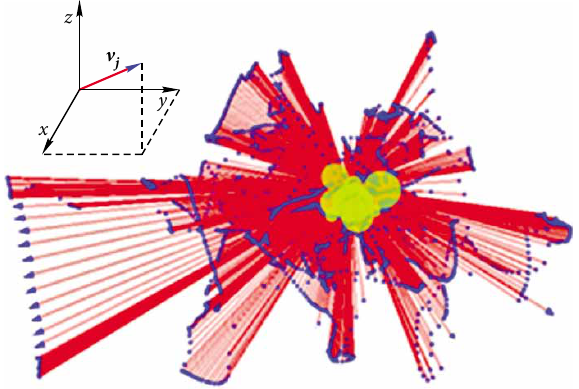
Fig. 17. Directions of the velocity vector of the i th particle in the quasistatic equilibrium